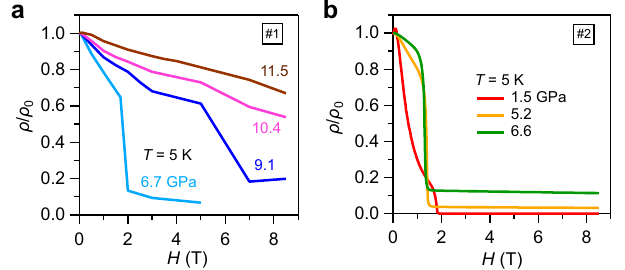
Fig. 4 Effect of pressure on the spin- fl op transition. Field dependence of normalized resistivity ρ / ρ 0 ( H ) at 5 K under different pressures for a sample #1 and b sample #2. The sudden drop of ρ / ρ 0 is associated with fi eld- induced spin- fl op orientations of magnetic fi eld with respect to the c -axis and will clarify it in the future study.